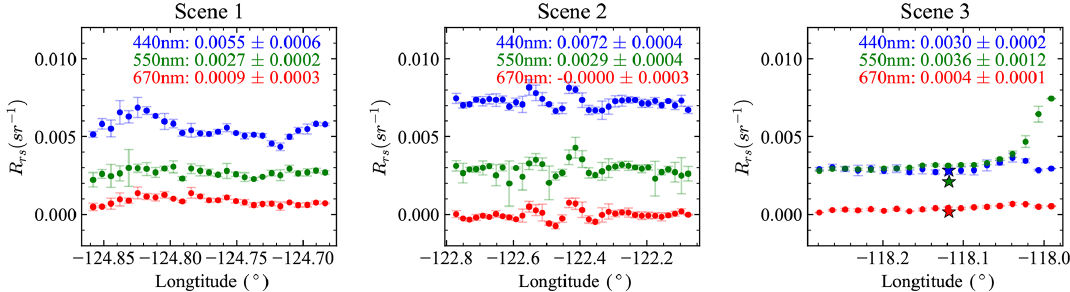
Figure 19. Similar to Fig. 18, the retrieved R rs values are computed for the AirHARP band of 440, 550, and 670nm bands. The averaged R rs and its standard deviation are shown in the legends. For Scene 3, R rs values from the AERONET USC_SeaPRISM site at wavelengths corresponding to AirHARP bands are indicated by the star